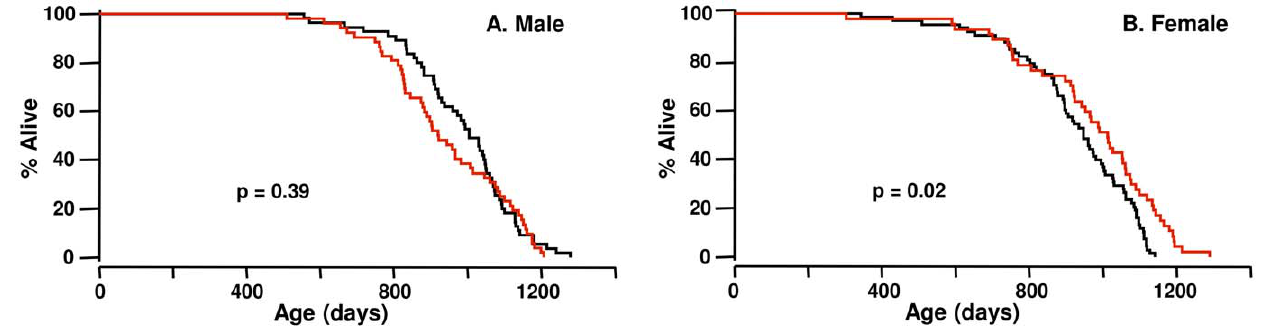
Figure 7. Longevity of WT and Igf1r + / 2 mice. The survival curves of 55 WT and 52 Igf1r + / 2 male mice (A) and 68 WT and 47 Igf1r + / 2 female (B) mice are shown in black for WT mice and red for Igf1r + / 2 mice. The survival curves were compared using the log-rank test, and the p-values are shown.